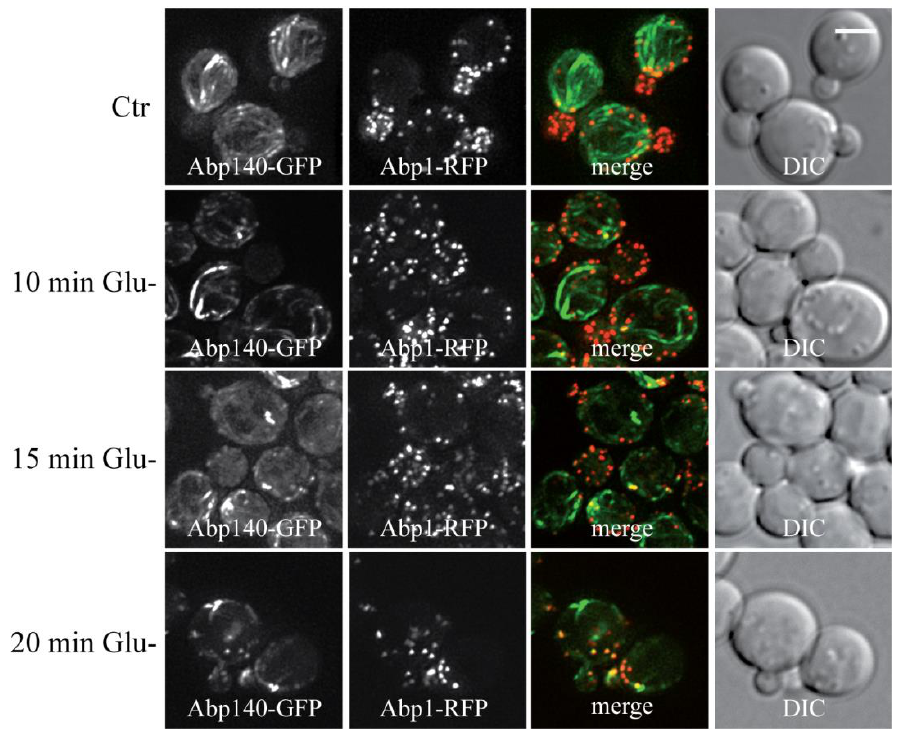
FIGURE 6: Detailed time course analyses of the glucose-depletion effect on S. cerevisiae (rho 0 ) live cells co-expressing Abp1-RFP and Abp140-GFP from chromosomal sites (strain CRY1454). The num- ber of Abp140-GFP filaments de- creased with time of glucose de- pletion. Distribution of fluorescent markers is presented after decon- volution and projection of several images in the stack (Z-stack) using Xcellence software (Olympus). Bar, 5